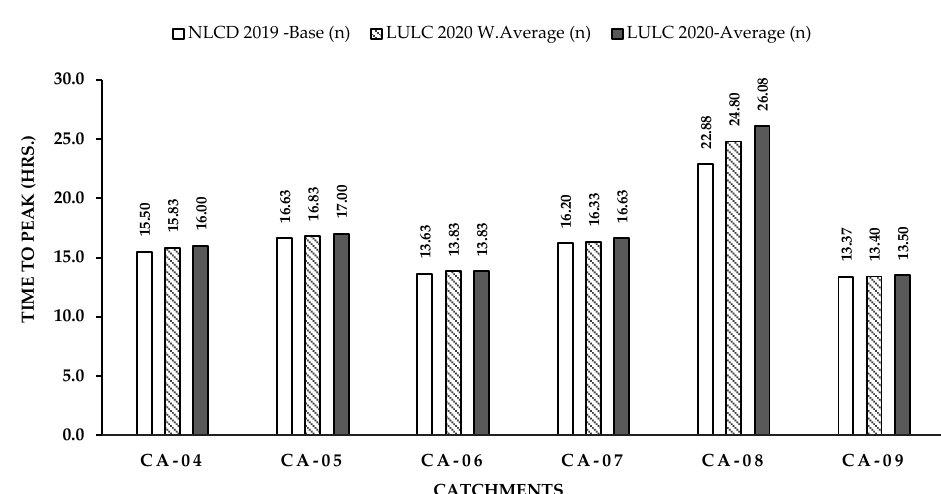
Figure 15. Time to peak flow in hours using LULC 2020-ESRI with ( n avg ) and ( n w.avg ), compared to base map validation results.